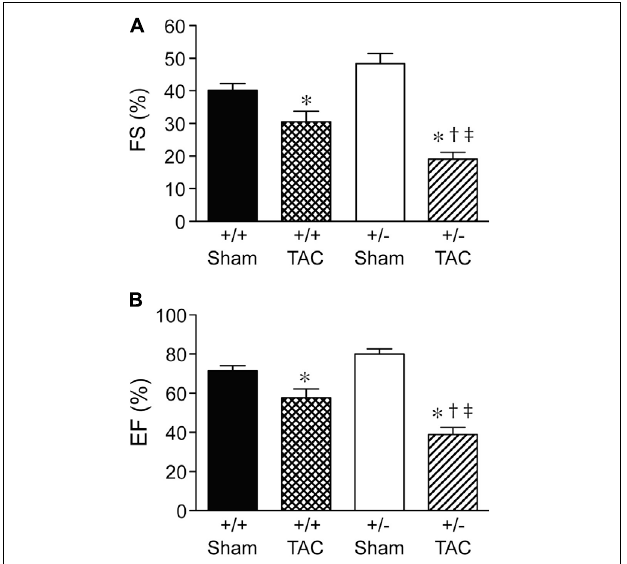
FIGURE 3 | Decompensation of left ventricular function in Speg + / − mice at 4 weeks post-TAC. Transverse aortic constriction (TAC) or sham surgery (sham) was performed on 8-week old Speg wild type (+/+) and heterozygous (+/–) mice. Echocardiography was performed on the mice (sham, n = 7/group; TAC, n = 7–11/group) after TAC or sham surgery. (A) Fractional shortening (FS, %) and (B) ejection fraction (EF, %) were assessed. Analysis by one-way ANOVA ( P < 0.05), with significant comparisons ∗ versus sham of the same group; † versus Speg + / + TAC; ‡ versus Speg + / + sham.